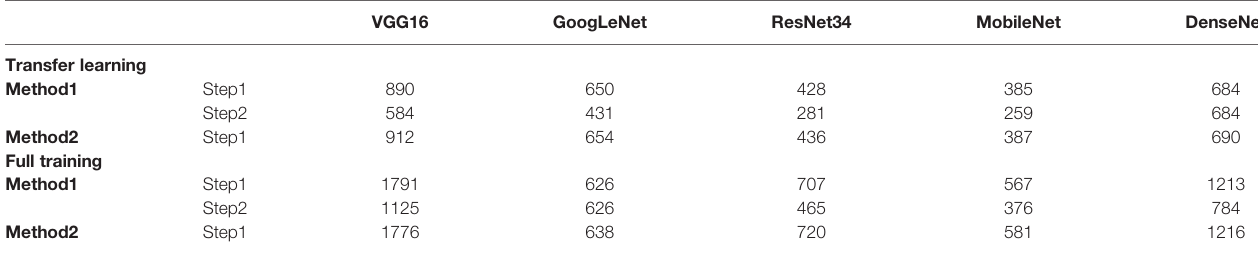
TABLE 3 | The training time of transfer learning and full training method with